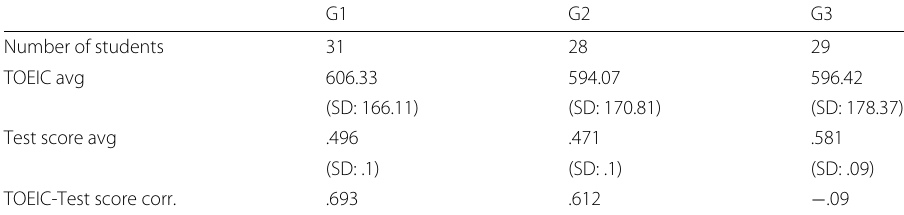
Table 5 Test scores vs. TOEIC score for each student group G1 G2 G3 Number of students 31 28 TOEIC avg 606.33 Test score avg .496 TOEIC-Test score